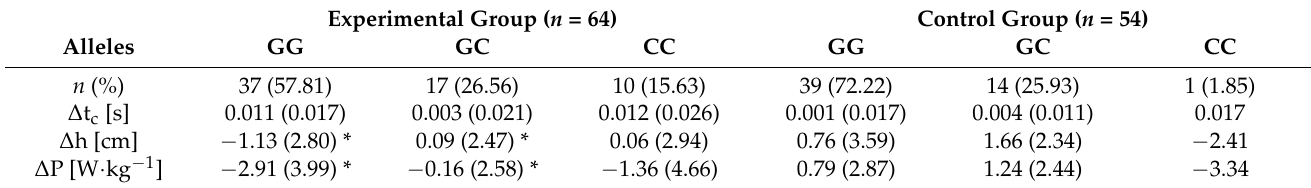
Table 5. Effect of PPARA gene on supercompensation effect in